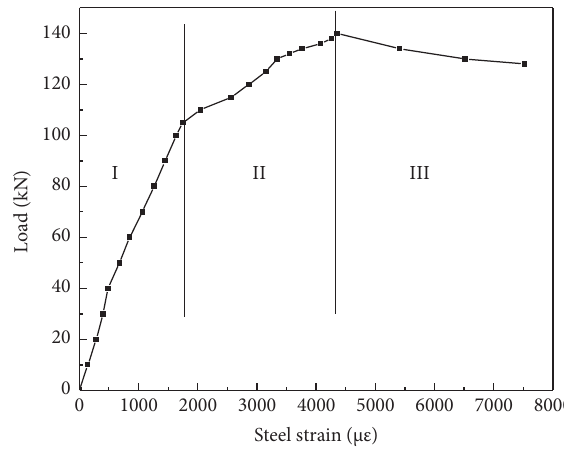
Figure 12: Load-steel bar strain